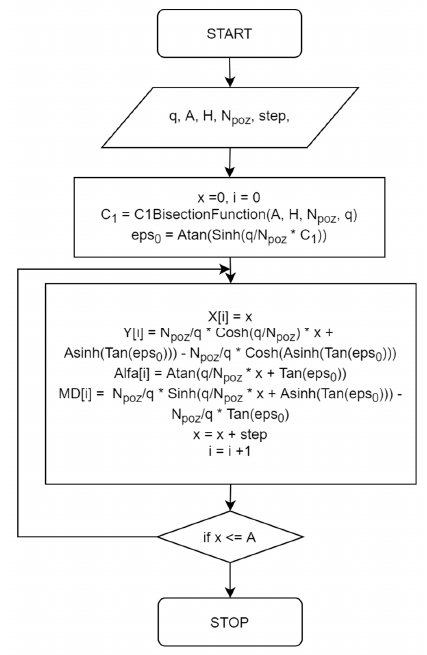
Figure 7. Simplified algorithm for calculating spatial points of the catenary